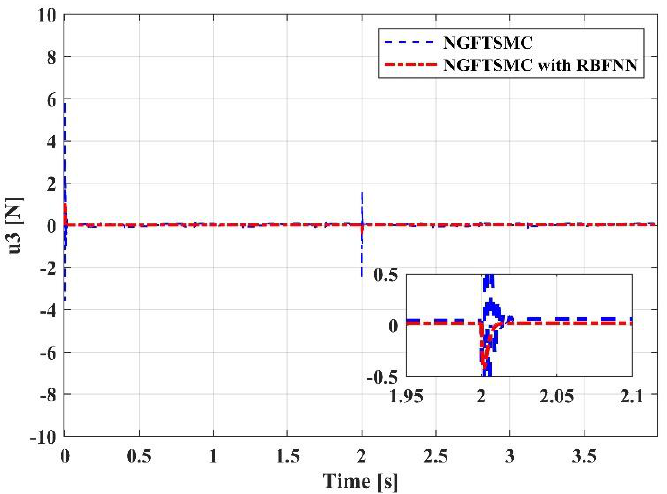
Figure 14. The performance of the control input 𝑢 3